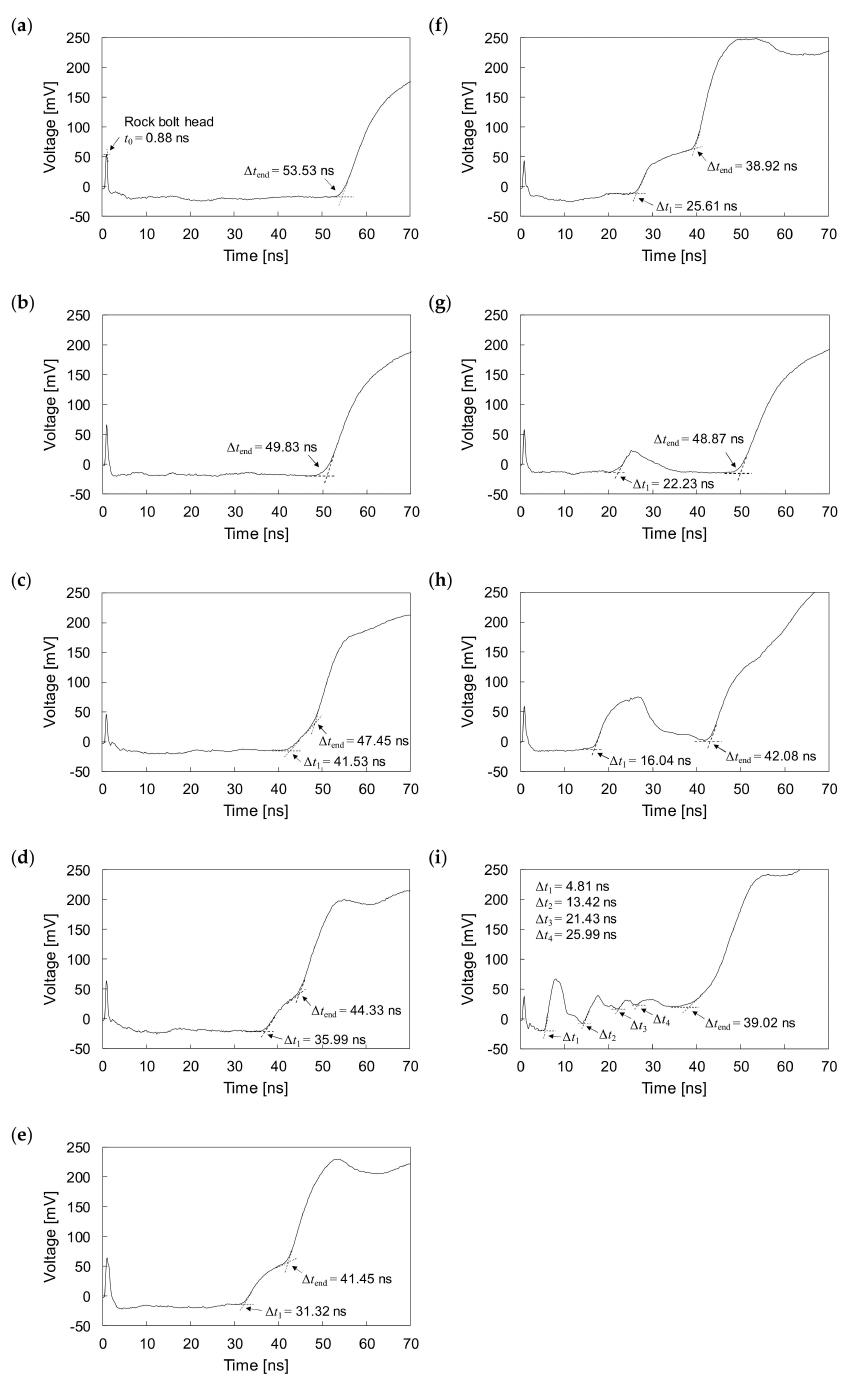
Figure 10. Measured signals in non-embedded rock bolts: ( a ) F0 (NGR = 0%); ( b ) D1 (NGR = 10%); ( c ) D2 (NGR = 20%); ( d ) D3 (NGR = 30%); ( e ) D4 (NGR = 40%); ( f ) D5 (NGR = 50%); ( g ) V1 (NGR = 10%); ( h ) V4 (NGR = 40%); ( i ) V5 (NGR =